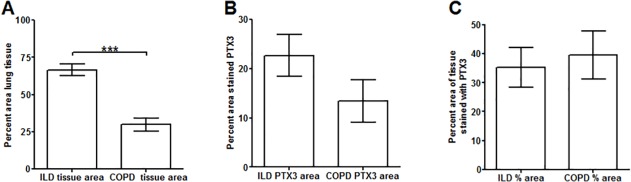
Quantification of PTX3 staining in COPD and pulmonary fibrosis lung tissue.A) The percentage of total area of image containing lung tissue, B) the percentage area of lung tissue stained by PTX3 antibodies, and C) the percentage of lung tissue stained by PTX3 antibodies as a percentage of the total area of the lung. Values are mean ± SEM, n = 7–9 patients per group. *** indicates p < 0.0001 (t-test).